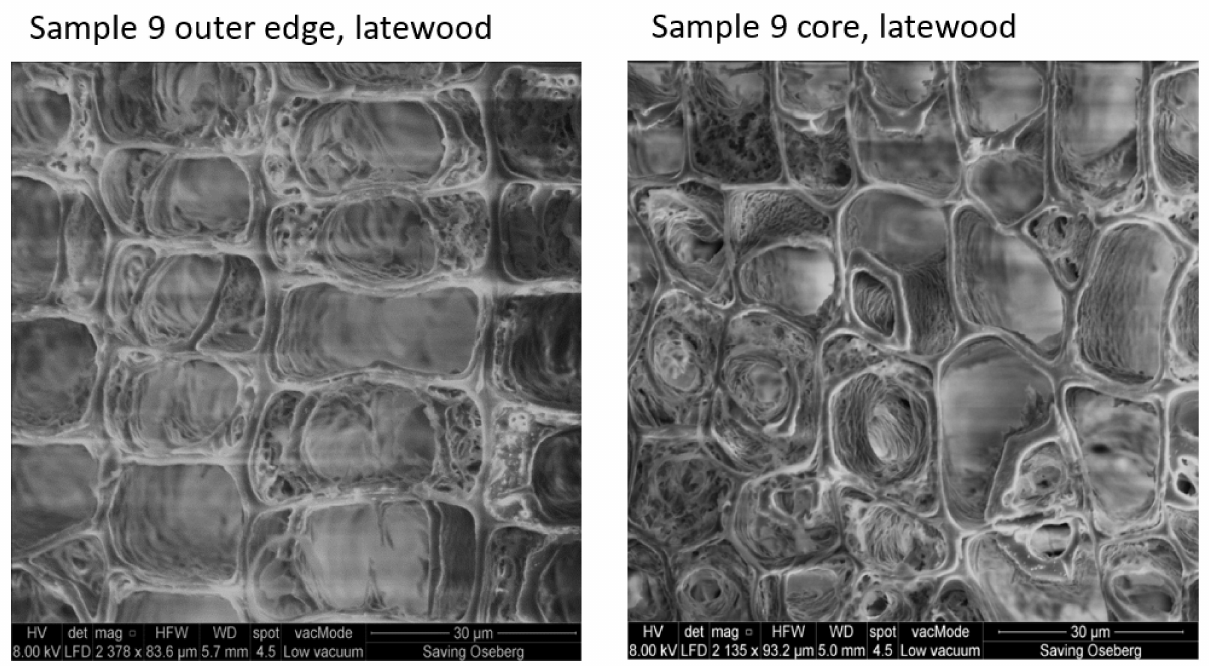
Figure 7. SEM images of the transverse faces of 30% P1000-treated sample 9. The left image is taken from the outer edge and the right image from the core of the sample. The spongy nature of the secondary walls appears to be reduced in the surface and only slightly reduced in the core, compared to the untreated reference shown in Figure 6. This may be attributed to the polymer within the cell walls in the surface.